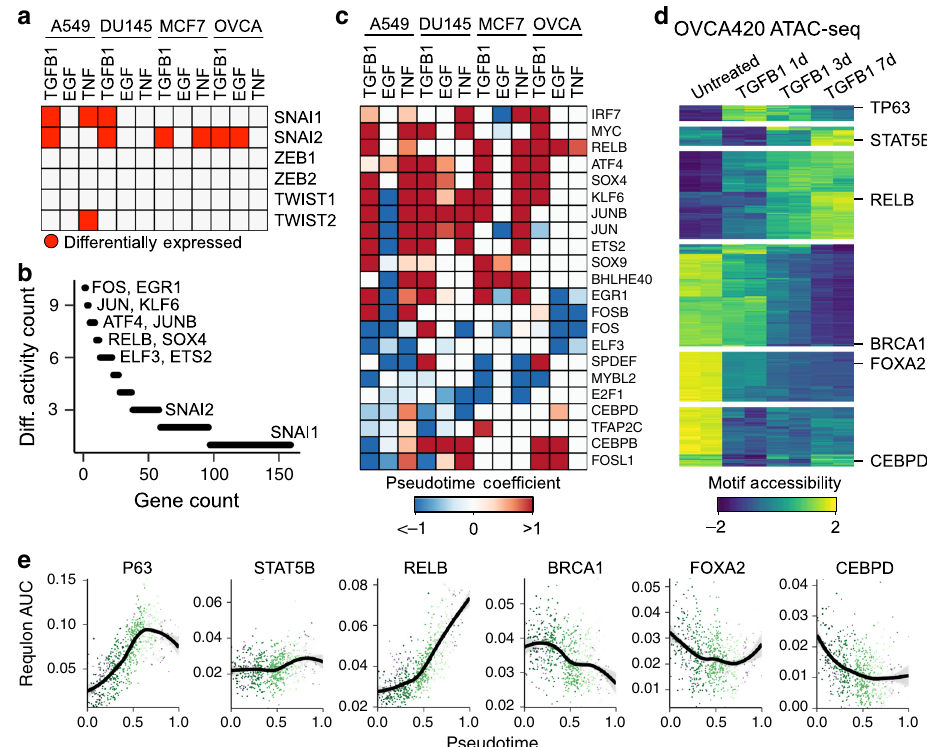
Fig. 3 Inferring transcription factor activity throughout the EMT. a Plot showing in which time course experiments various canonical EMT transcription factors are differentially expressed. b Counts of how frequently various transcription factors and their associated regulons are differentially active among time course experiments. c Heatmap showing EMT-associated changes of regulons that are differentially active in at least six time course experiments. The colormap corresponds to the pseudotime beta coef fi cient of a linear model for each regulon. d Differential accessibility of transcription factor motifs from ATAC-seq data of OVCA420 cells treated with TGFB1 for 0, 1, 3, or 7 days. The colormap represents the accessibility Z -score for each transcription factor motif. Examples of transcription factors from each cluster are listed. e Regulon activity score of the same transcription factors listed in d inferred from the OVCA420 TGFB1 time course experiment. Each dot represents a single cell, colored by time point. The black line corresponds to the modeled trend from a generalized additive model. Shaded bands for each line correspond to the standard error for each